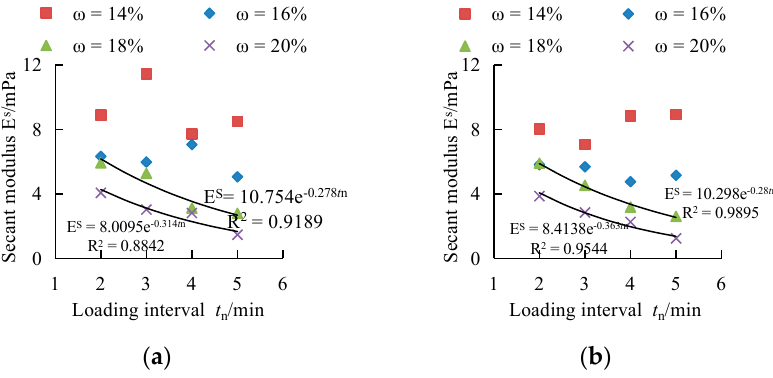
Figure 11. Secant modulus at different loading intervals: ( a ) ρ d = 1.37 g/cm 3 ; ( b ) ρ d = 1.46 g/cm 3 .